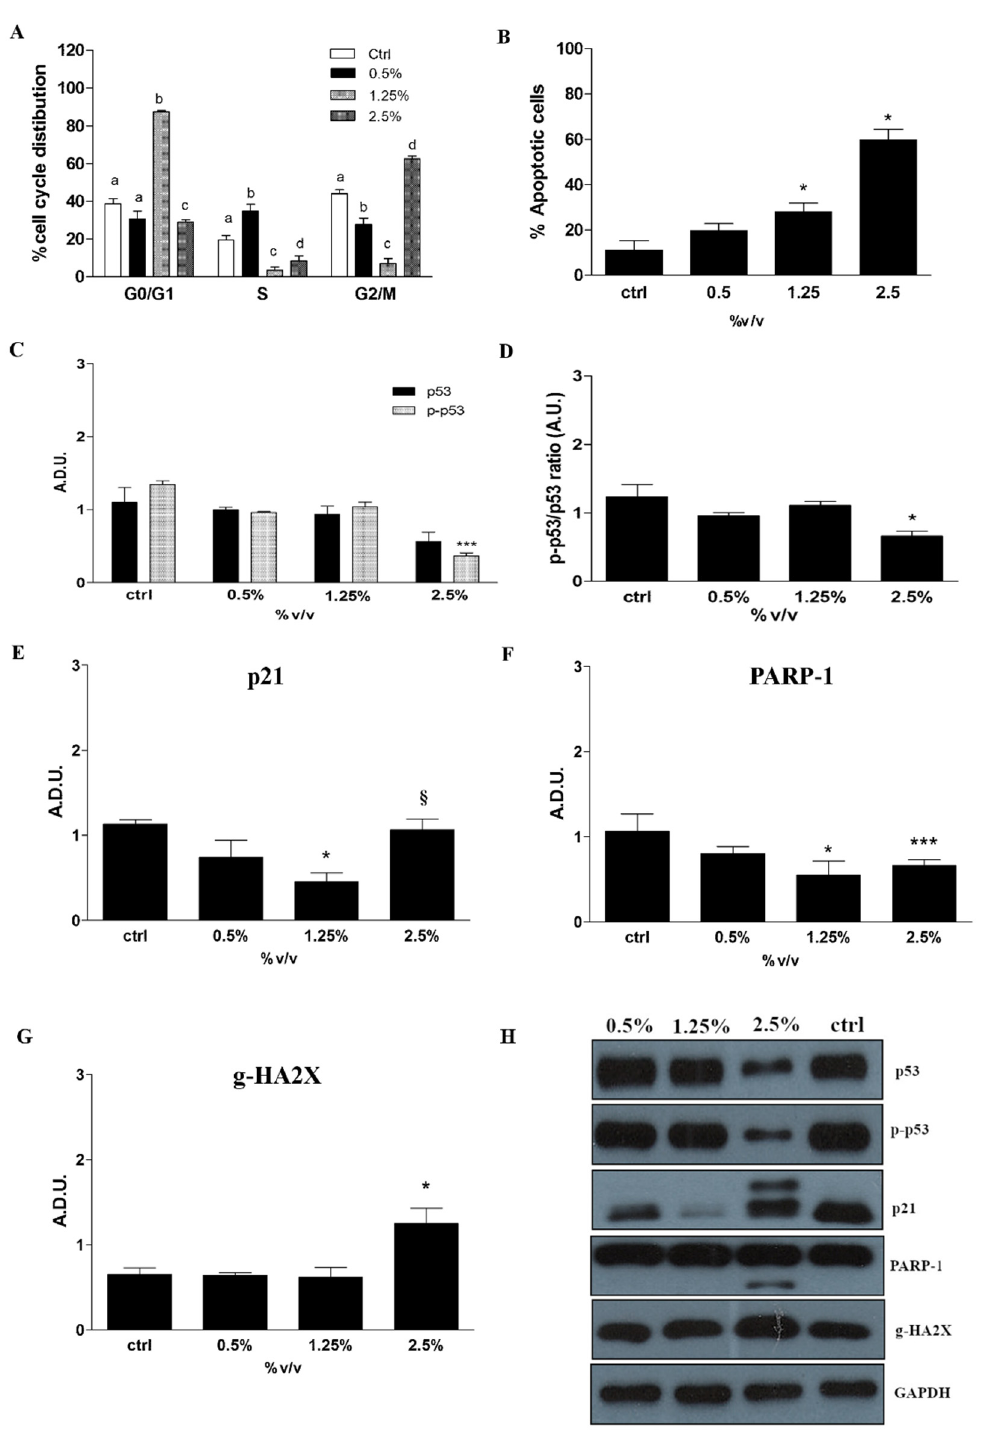
Figure 8. Cell cycle analysis, apoptosis determination and protein expression levels in 1321N1 cells untreated and treated with di ff erent concentrations of Rapha Myr ® extract (0.5–1.25–2.5% v / v ) for 24 h. ( A ) Cell cycle analysis performed by flow cytometry using propidium iodide DNA staining. The graph shows the percentage of 1321N1 cell distribution in di ff erent cell cycle phases. Bars that do not share the same letter are significantly di ff erent. ( B ) Apoptosis measured by flow cytometry and Annexin-V / PI co-staining. The bar graph shows the percentage of apoptotic cells (Annexin-V-positive, PI-negative and -positive). Western blot of p53 and p-p53 ( C ), p-p53/p53 ratio ( D ), p21 ( E ), PARP1 ( F ) and γ H2AX ( G ). Each bar graph shows the relative expression of the respective protein level. ( H )